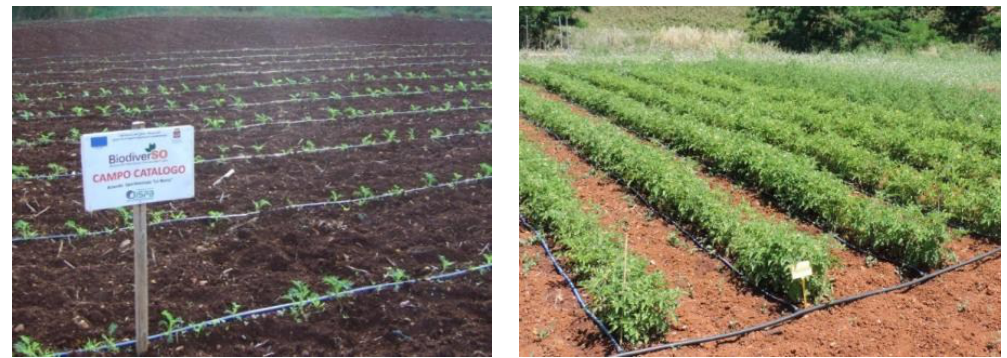
Figure 4. Catalog fields of Brassicaeae ( left ) and different local varieties of Solanum lycopersicum L. ( right ) within “La Noria” experimental farm of the National Research Council, Bari, Italy.